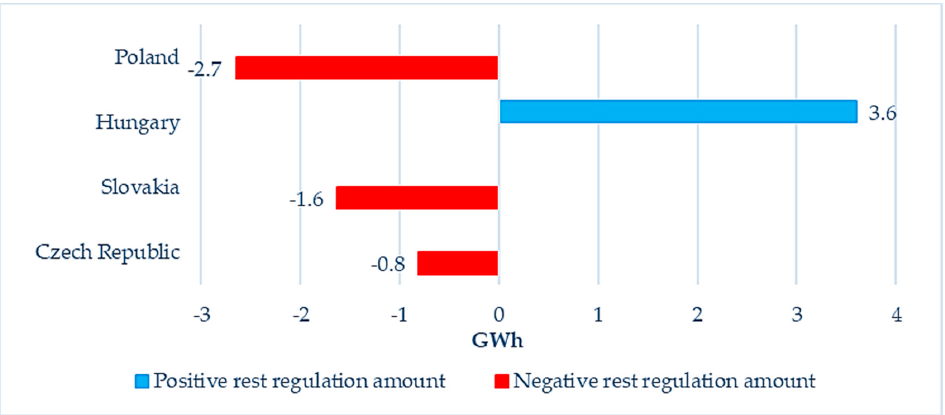
Figure 4. The balance of the negative and positive required energy regulation in the Visegrad countries in the period of 1 September 2019 to 31 August 2020.